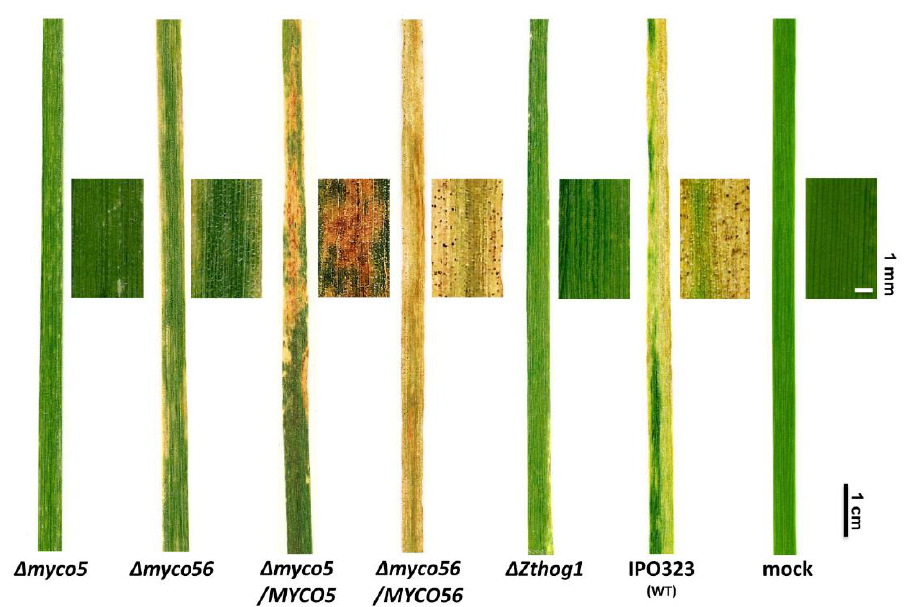
Figure 2. Virulence of Z. tritici ∆ myco5 and ∆ myco56 strains. The effects of the gene deletion on disease development in the susceptible wheat cv. Riband after 21 days after inoculation (dpi) are indicated. The wild-type IPO323 and ∆ Zthog1 are used as positive and attenuated virulence controls, while “mock” is a negative control (inoculated with water only). Infections were carried out at 22 ◦ C with 80% humidity and a 16 h/8 h light cycle. The strain ∆ myco5 proved to be non-pathogenic, while ∆ myco56 strains, such as ∆ Zthog1 , are severely reduced in virulence. Successful infection was observed for IPO323, which formed mature pycnidia at 21 dpi. Full virulence was completely restored for the complementation strains ∆ myco5 / MYCO5 and ∆ myco56 / MYCO56 generated by reintroduction of the full-length genes in the respective mutants.